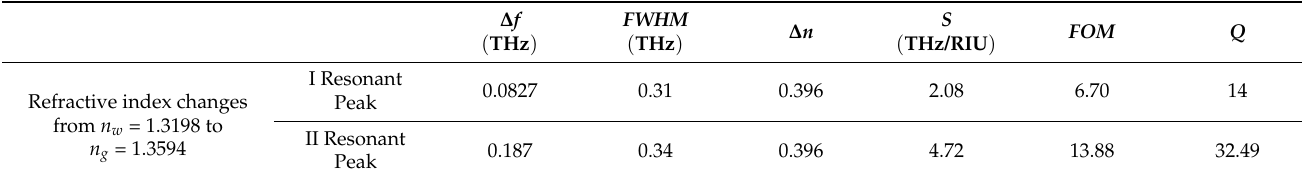
Table 2. Performance of the proposed absorber for sensing 25% glucose in water.